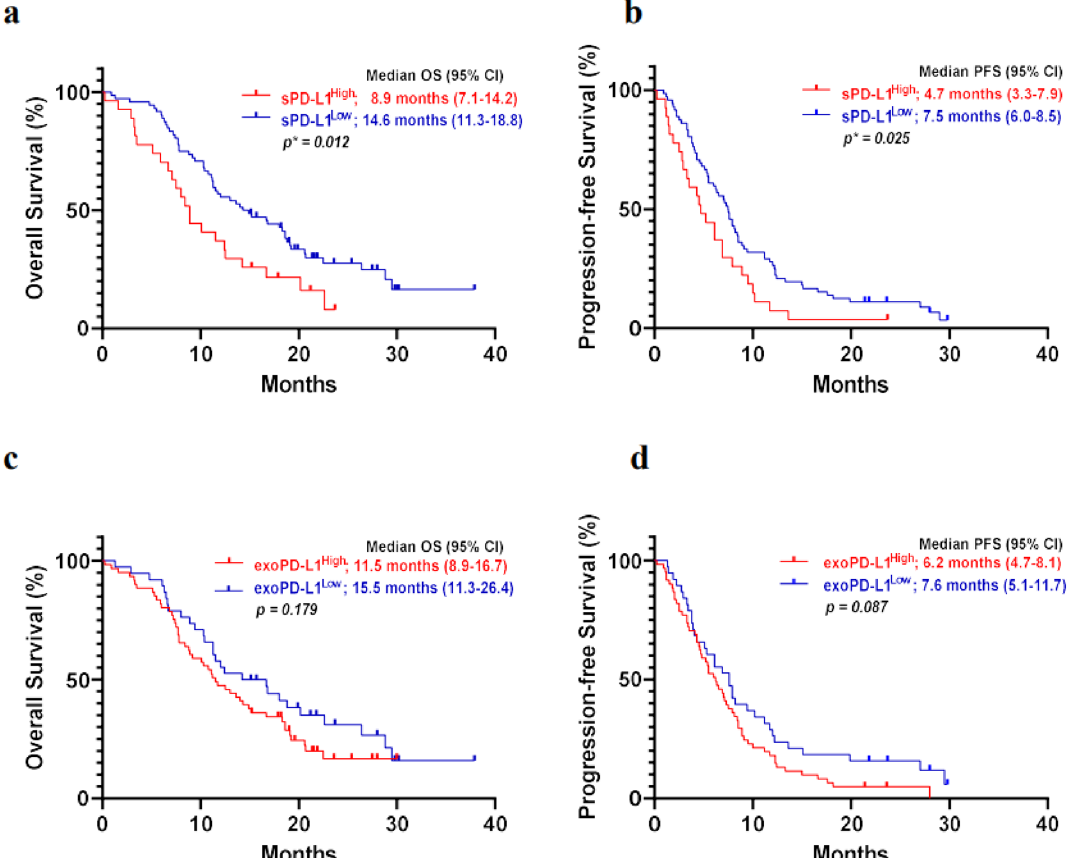
Figure 1. Survival between soluble and exoPD-L1 high and low groups. ( a , b ) OS and PFS in the low sPD- L1 group was longer than that in the high sPD-L1 group ( c , d ). OS and PFS were not different between the exoPD-L1 groups.